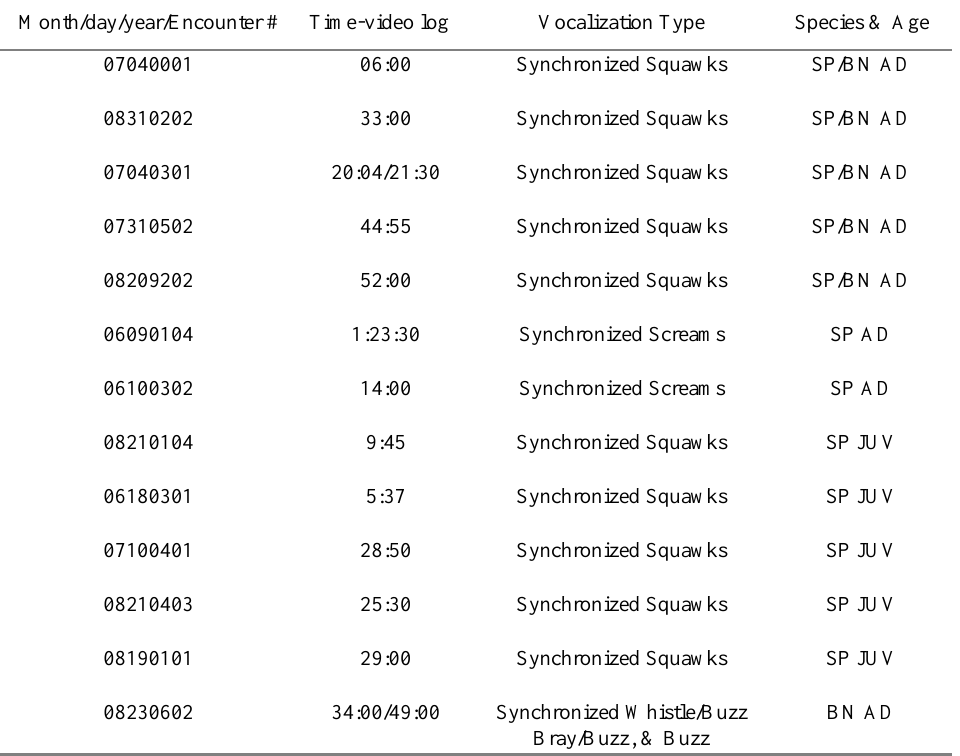
Description of Dolphin Encounters that Contained Synchronous or Rhythmic Vocalizations. (SP = Spotted dolphin, BN = Bottlenose dolphin, AD = adults, JUV =